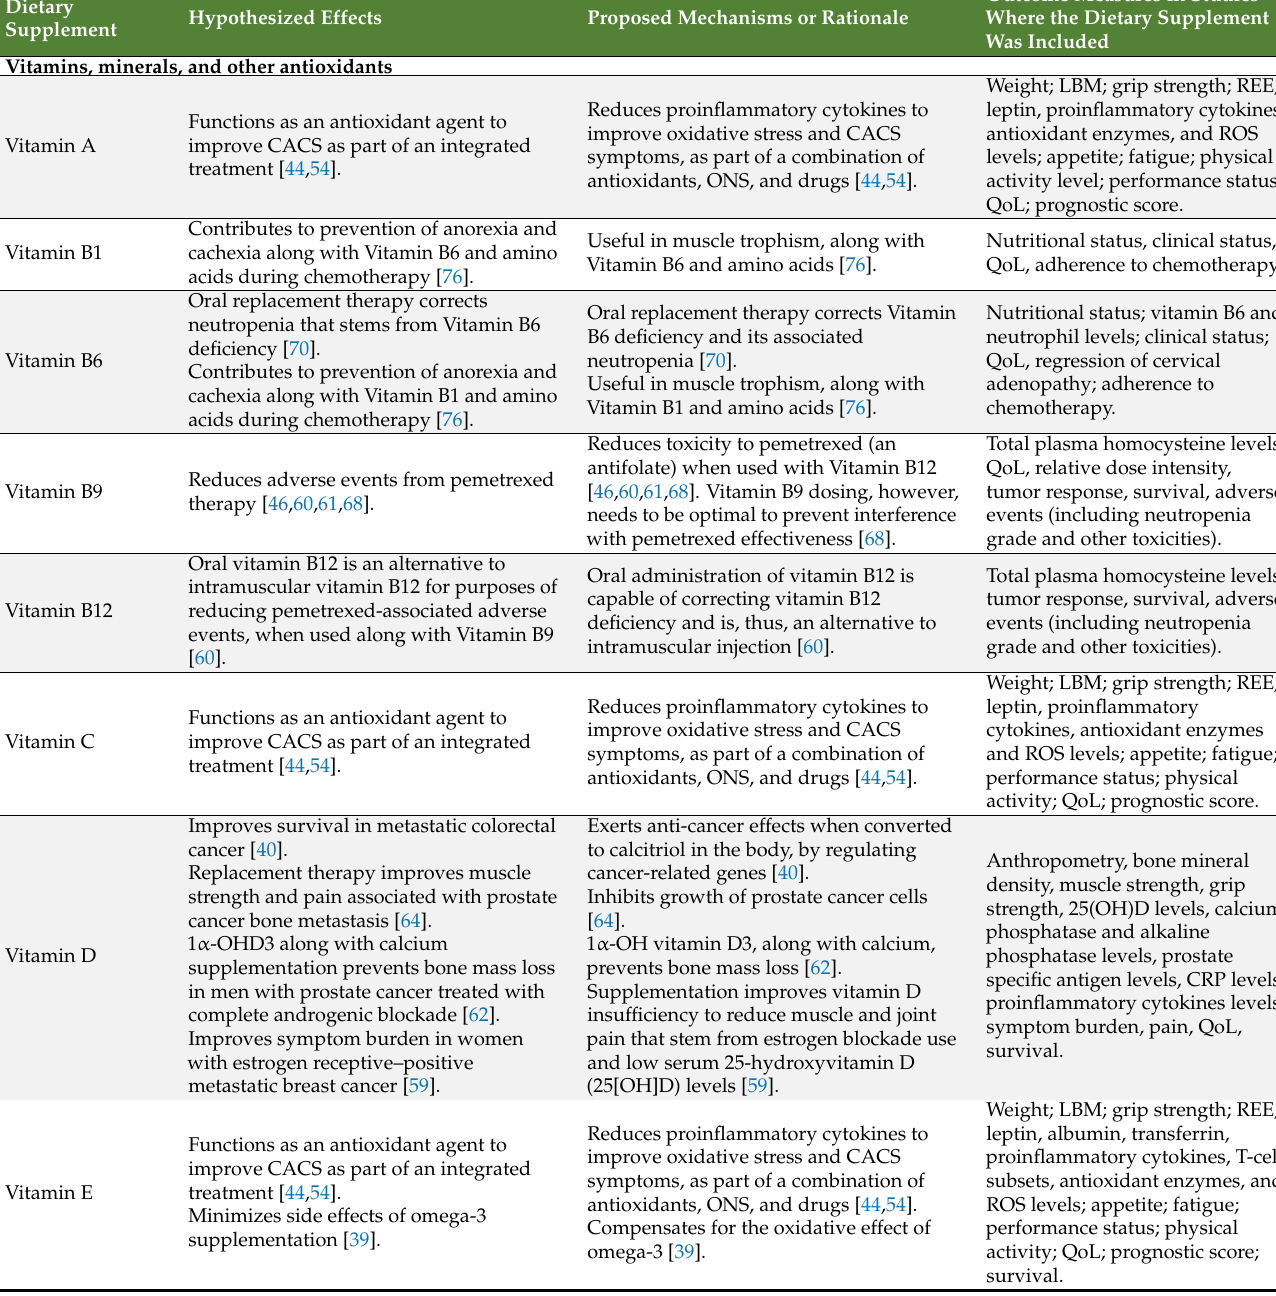
Table 4. Hypothesized effects of dietary supplements, mechanisms/rationale, and outcomes